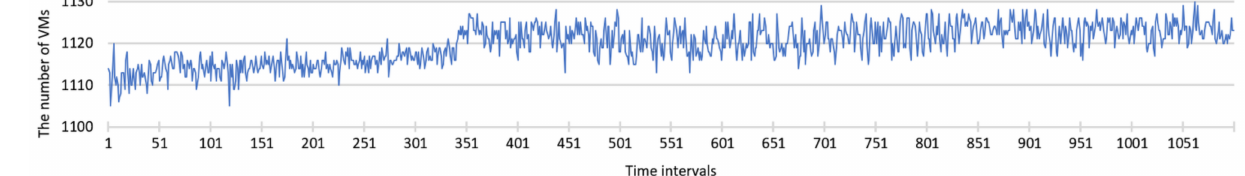
Figure 1. The number of VMs running on PMs during each simulation. Bitbrains workload traces represent resource usage of Web, database, or application servers by 1250 VMs that belong to 44 different classes [26]. Each VM trace file contains data about CPU, memory, storage, and network interface usage.